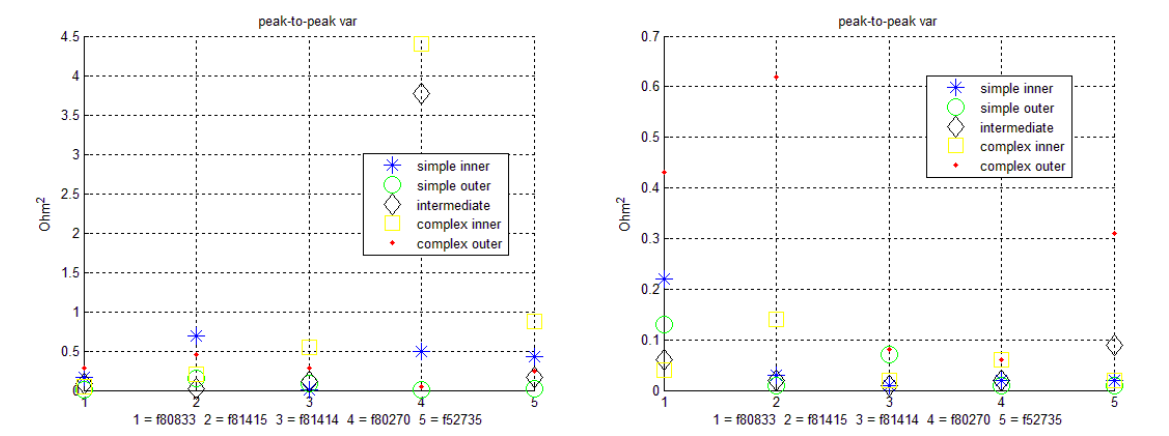
Figure 16. Peak-to-peak variance: ( left ) un-insulated case; ( right ) insulated